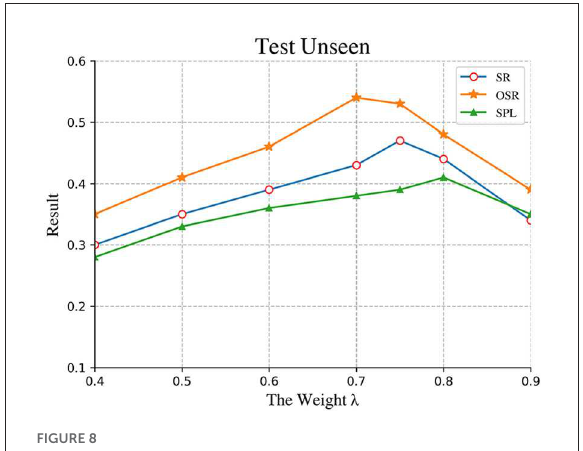
FIGURE8 Comparison of performance on the different weight of scoring module. The best result is approximately obtained when the is equal to 0.75.